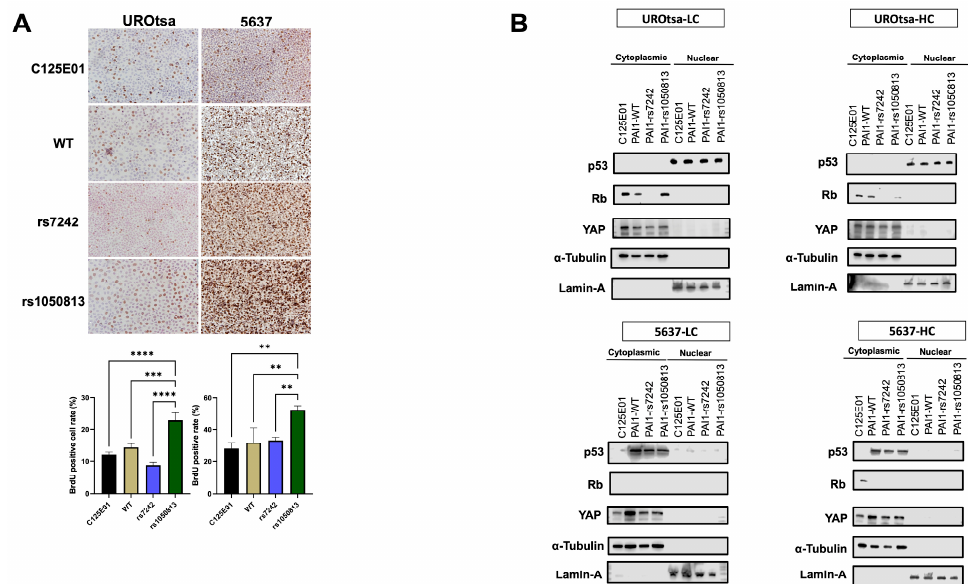
Figure 4. PAI1 rs1050813 aborts cell–cell contact inhibition. ( A ) Evaluation of cell proliferation in high-cell density/confluency condition by ICC for BrdU. ( B ) Protein levels of p53, Rb, and YAP in subcellular fractions. Bars represent SE. ** p < 0.01; *** p < 0.001, **** p < 0. 0001.